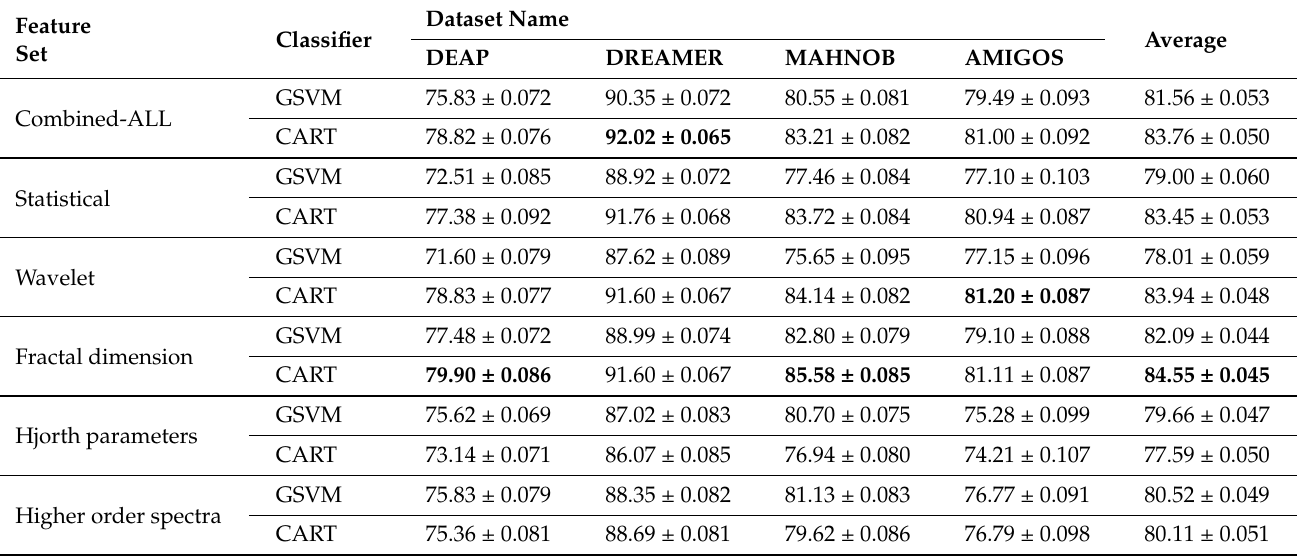
Table 4. Emotional Arousal: Mean (±SD) EEG Feature-classification accuracy (%). Bold represents the highest average accuracy scores within and across each